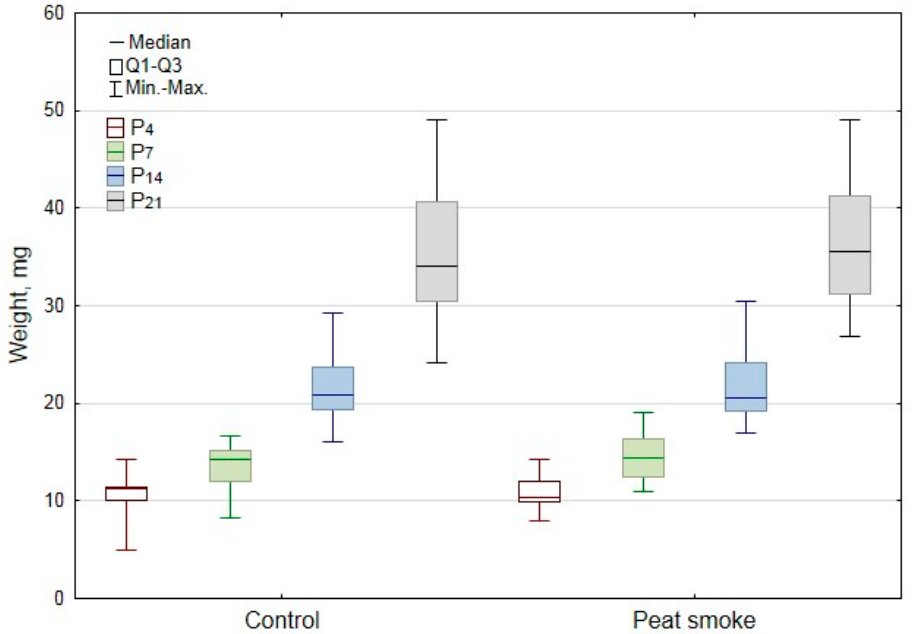
Figure 4. Body weight of newborn offspring on postnatal days P4, P7, P14, and P21. Adult F1 rats were tested in the open field test, and electroencephalographic exam- ination was carried out. In F1 offspring obtained from males exposed to natural fire smoke for 1 day, pronounced gender differences in the structure of behavior in an open field were revealed. Females showed a pronounced activation of locomotor activity, as evidenced by a statistically significant increase in both horizontal (distance) and vertical activity (rearing) compared with control indicators ( p = 0.033 and p = 0.003, respectively, Figure 5). The behavior of F1 offspring males had no statistically significant differences when compared with the control group.